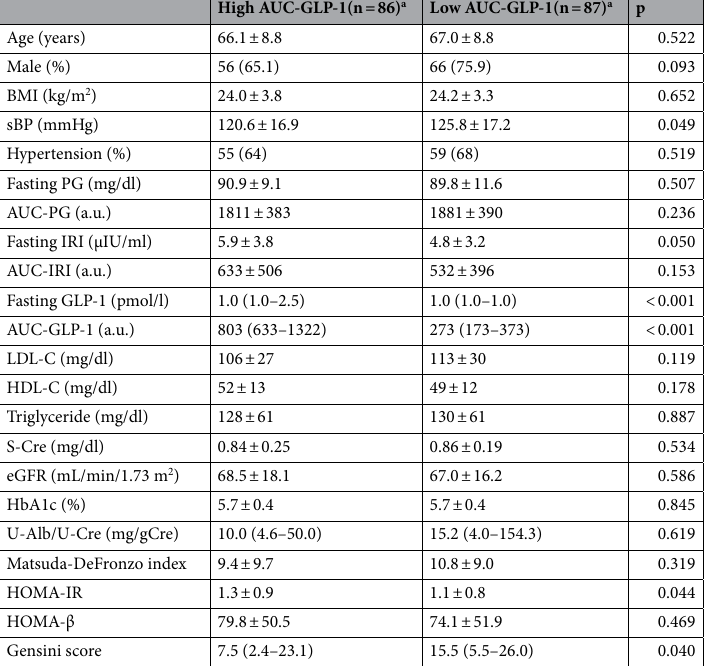
Table 3. Baseline characteristics of patients grouped according to AUC-GLP-1 being higher or lower than its median value. sBP: systolic blood pressure; BMI: body mass index; PG: plasma glucose; IRI: immunoreactive insulin; LDL-C: LDL cholesterol; HDL-C: HDL cholesterol; S-Cre: serum creatinine; eGFR: estimated glomerular filtration rate; HbA1c: hemoglobin A1c; U-Alb/U-Cre: ratio of urinary albumin to urinary creatinine. Data are means ± SD or medians (interquartile ranges). a Patients with higher or lower level of AUC- GLP-1 than median value